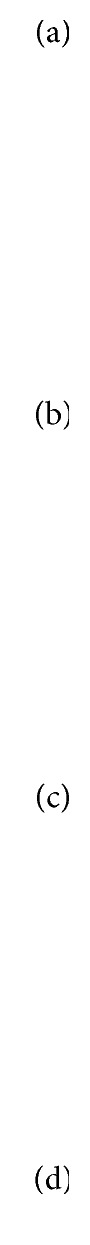
The neoplastic cells expressed CK8/18 (a), CD10 (b), PAX8 (c), and vimentin (d), being consistent with metastasis of clear cell renal carcinoma.